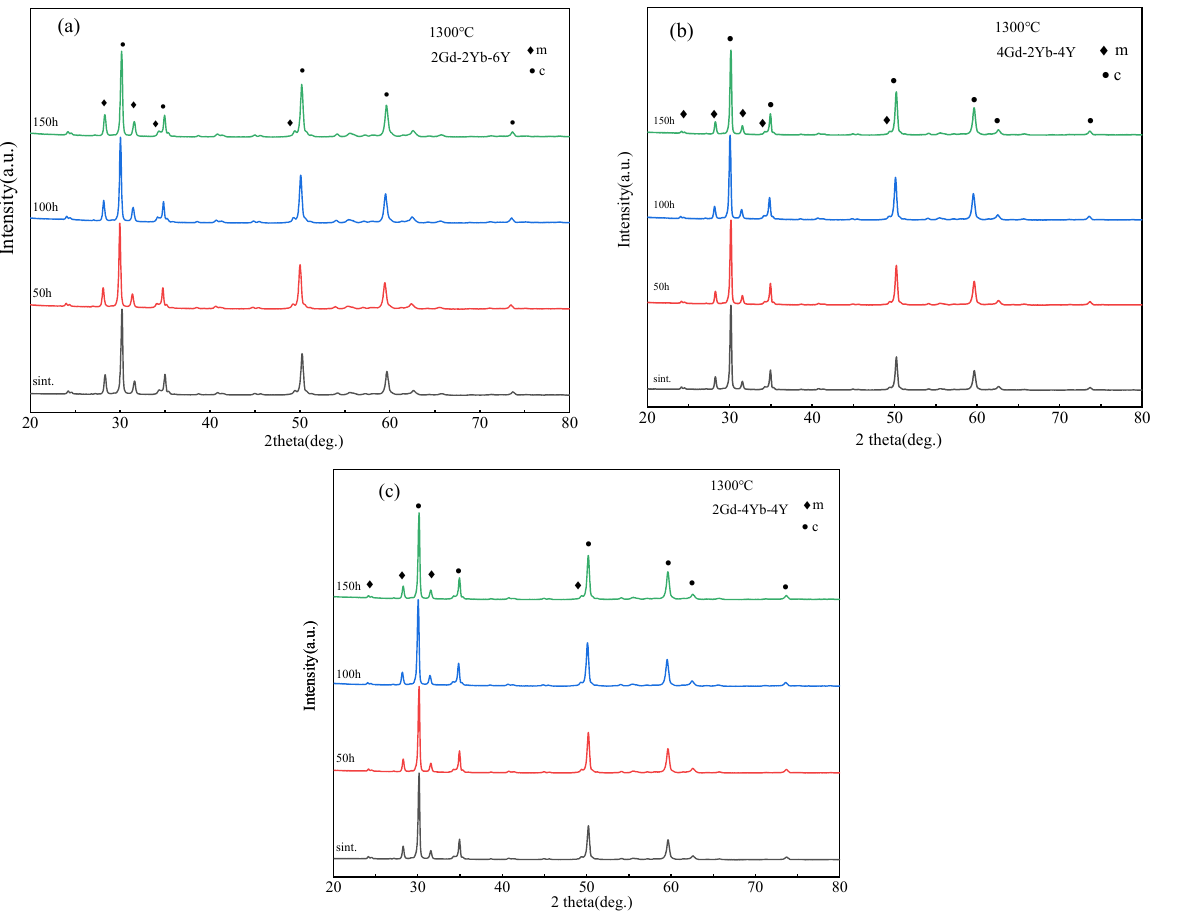
Figure 3. XRD patterns of ( a ) 2Gd-2Yb-6Y, ( b ) 4Gd-2Yb-4Y and ( c ) 2Gd-4Yb-4Y powders after 50, 100 h and 150 h at 1300 °C .